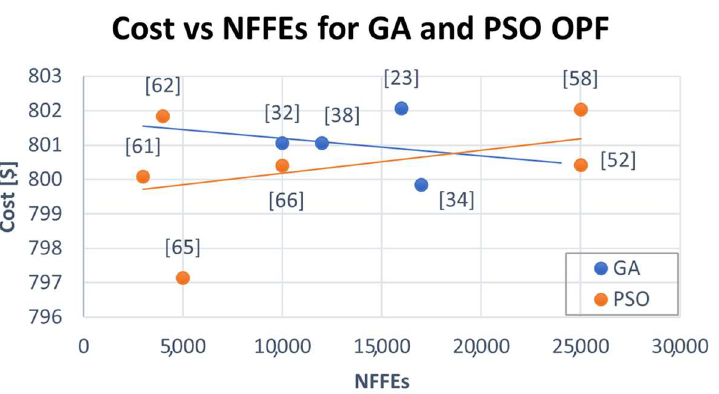
Figure 3. Cost vs. NFFES and trend lines of the GA OPF works in Table 5 (blue dots and line) and the PSO OPF works in Table 6 (orange dots and line).